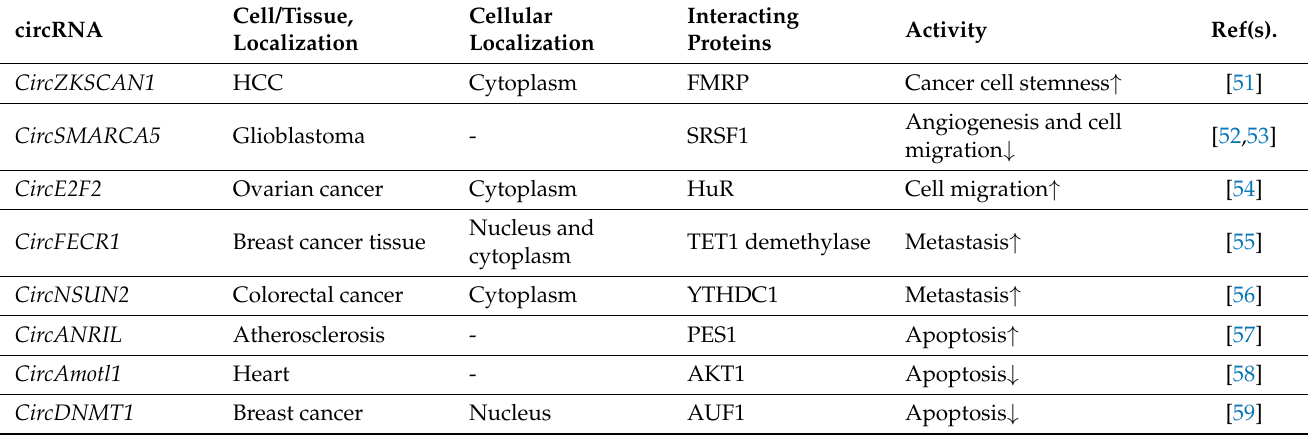
Table 2. Functions of circRNA–protein interactions. ↑ represents upregulation and ↓ represents inhibition. circRNA